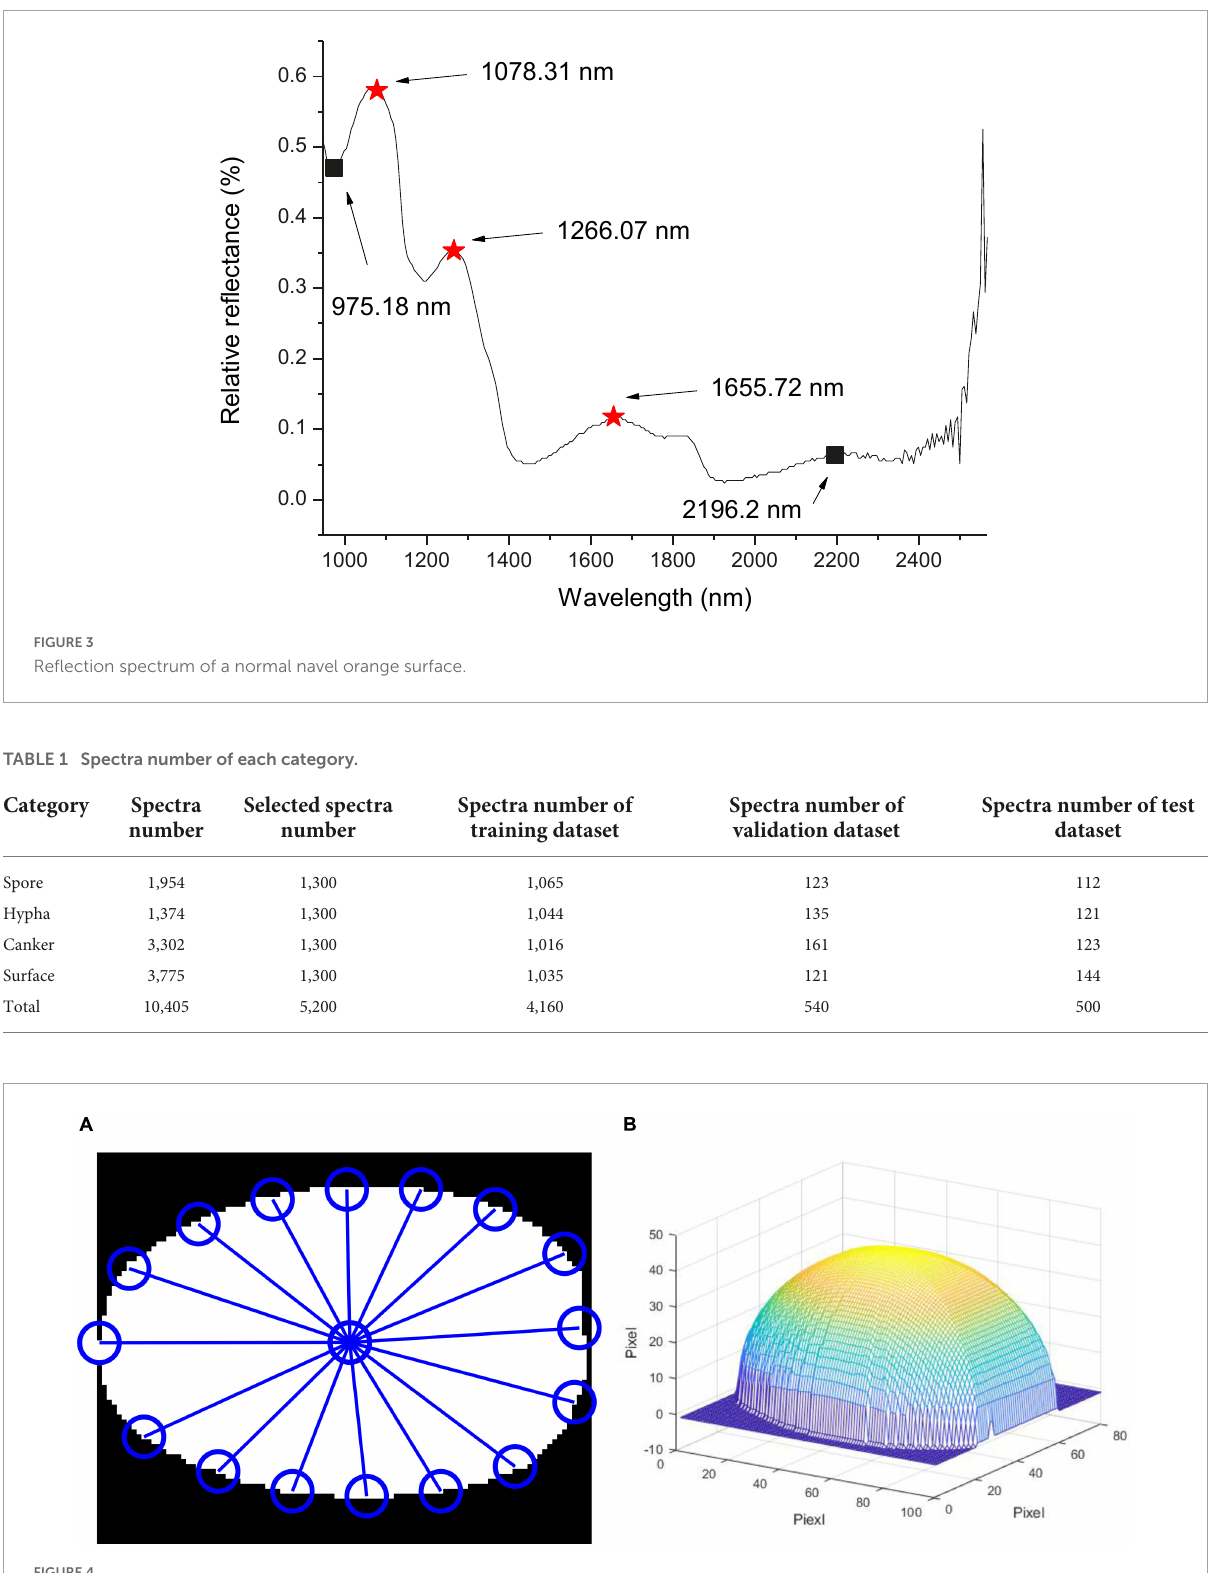
FIGURE4 Correction of the spherical fruit. (A) segmentation of the mask image, (B) 3D reconstruction of spherical